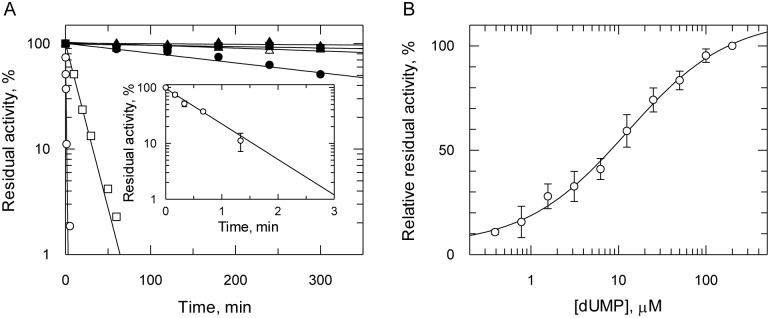
Stabilisation of recombinant T. brucei TS activity by substrate dUMP.A. Determination of TS stability relative to dUMP concentration using Tsf-TbDHFR-TS from thyA- lysate. Tsf-TbDHFR-TS (circles), LmDHFR-TS (squares), human TS (triangles). Incubation mixtures omitted either 200 μM dUMP (open symbols) or 100 μM CH2THF (closed symbols); post-incubation, addition of the missing reagent was used to initiate reactions. The inset shows the loss of TS activity Tsf-TbDHFR-TS in absence of dUMP over a shorter time scale. All activities were determined in triplicate spectrophotometrically using 100 μM CH2THF, as described in the methods. B. Optimum concentration of dUMP required to stabilise the TS activity. Activity was determined by incubating the diluted lysate for 10 min in assay buffer with varying concentrations of dUMP prior to initiation of the reaction with CH2THF and excess (200 μM) dUMP.